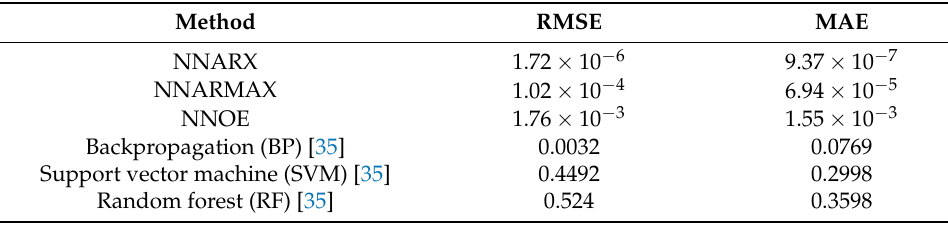
Table 4. Comparison results of prediction accuracy with previous